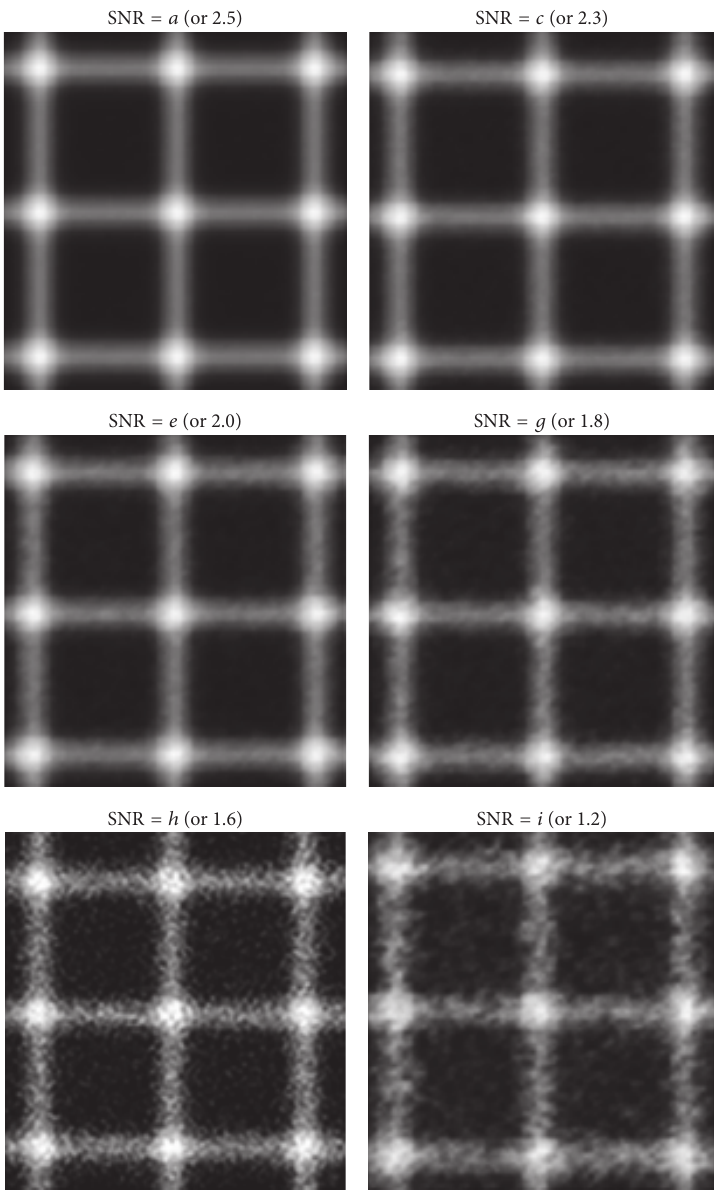
Figure 7: Synthetic images of various SNR values with LW = 11